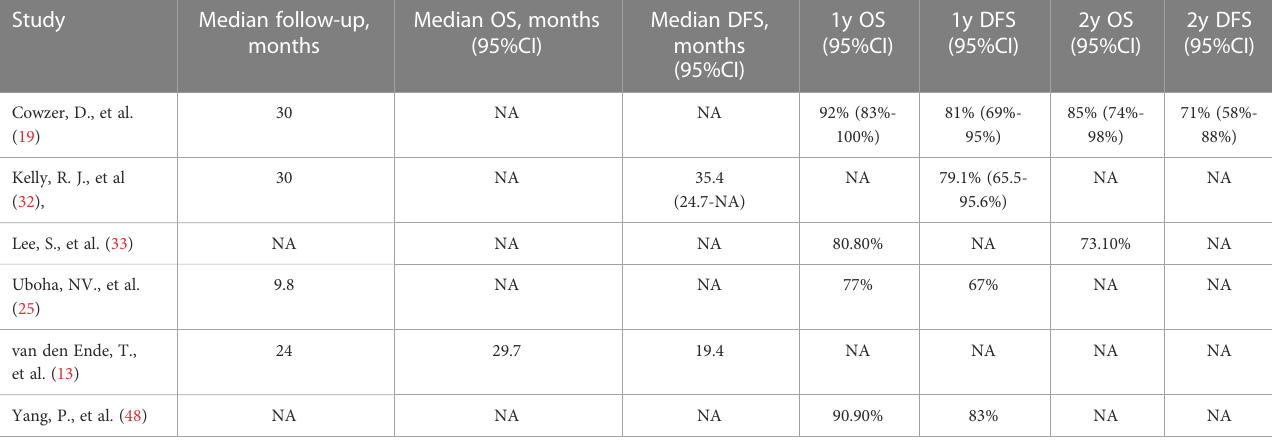
TABLE 3 Survival